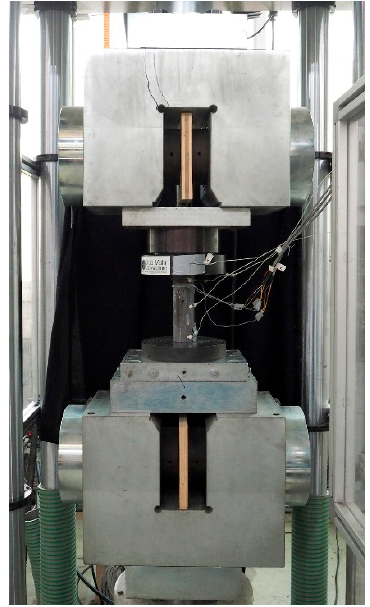
Figure 3. Testing machine during an experiment.